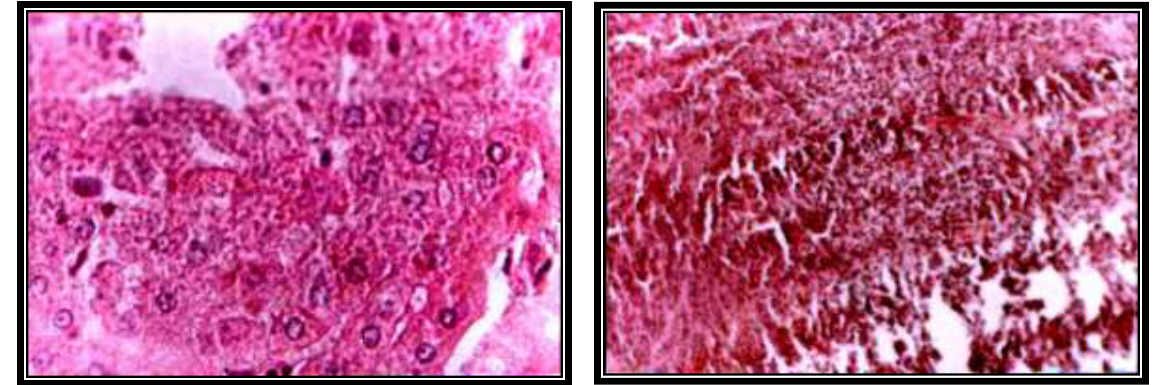
Figure 2 : cross section in rat lung (T1)